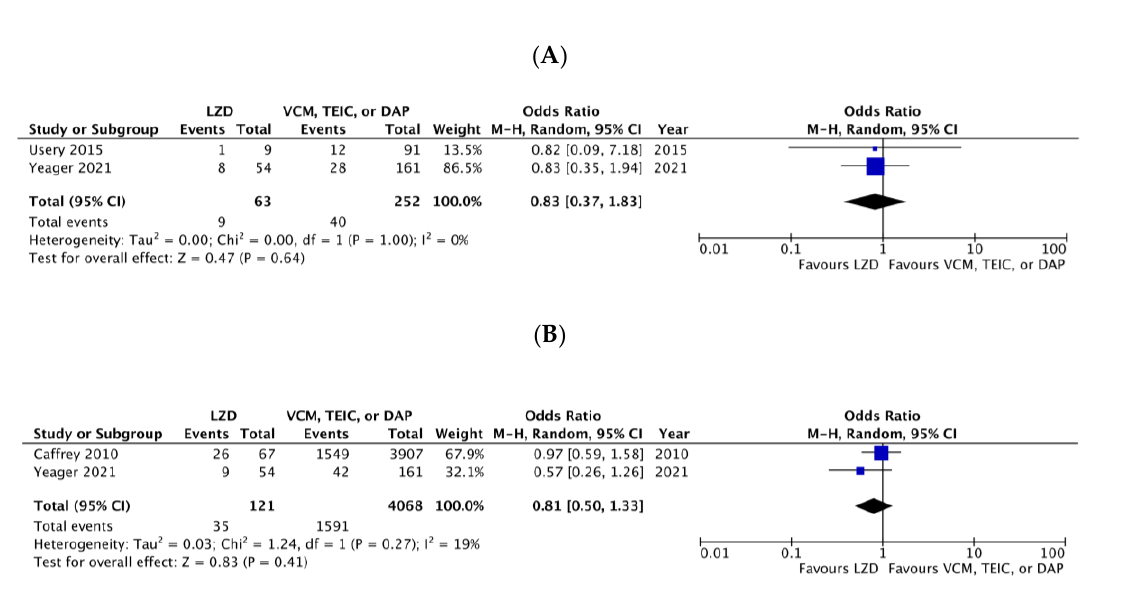
Figure 6. Forest plots of recurrence and 90-day readmission rates in patients with MRSA bacteremia treated with LZD versus VCM, TEIC, or DAP. ( A ) recurrence rates; ( B ) 90-day readmission rates. The vertical line indicates no significant difference between the groups compared. Mantel–Haenszel ORs are represented by diamond shapes, and 95% CIs are represented by horizontal lines. Squares indicate point estimates, and the square size indicates the weight of each study included in the meta-analysis. MRSA, methicillin-resistant Staphylococcus aureus ; CI, confidence interval; LZD, linezolid; VCM, vancomycin; TEIC, teicoplanin; DAP,